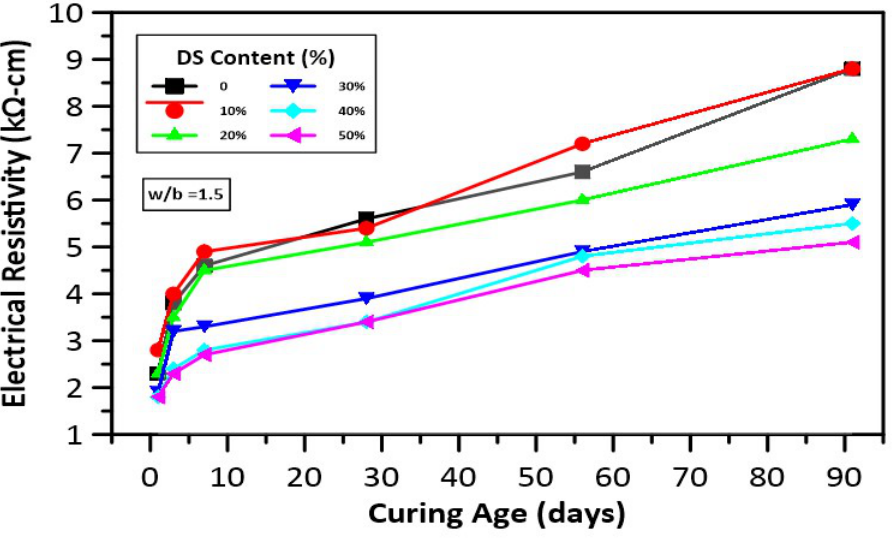
Figure 4. The relationship between the curing age and surface resistivity of the CLSM.